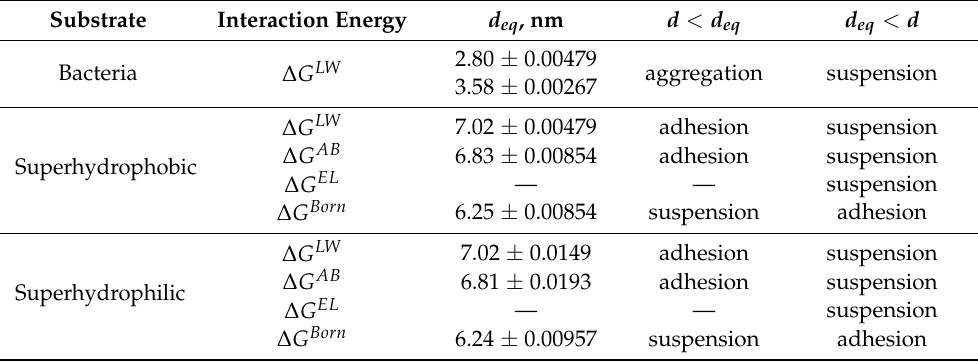
Table 3. d eq and effect of bacterial approach to a defined substrate accounting for bacteria-substrate interaction geometries and bacterial surface